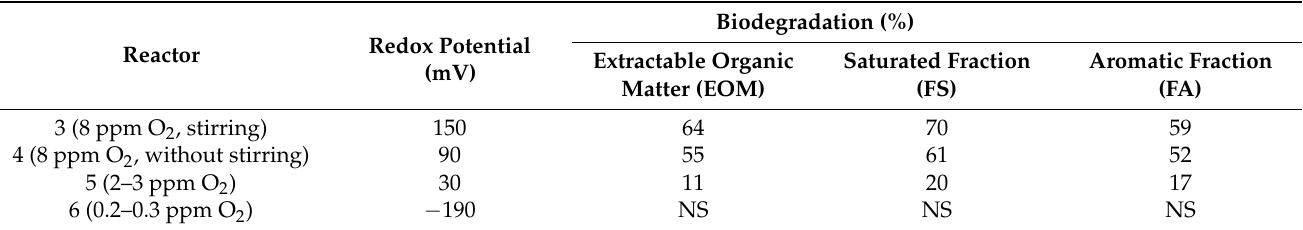
Table 1. Percentage of biodegradation of spilled oil in sediments after a 60-day incubation. Adapted from Mille, et al.